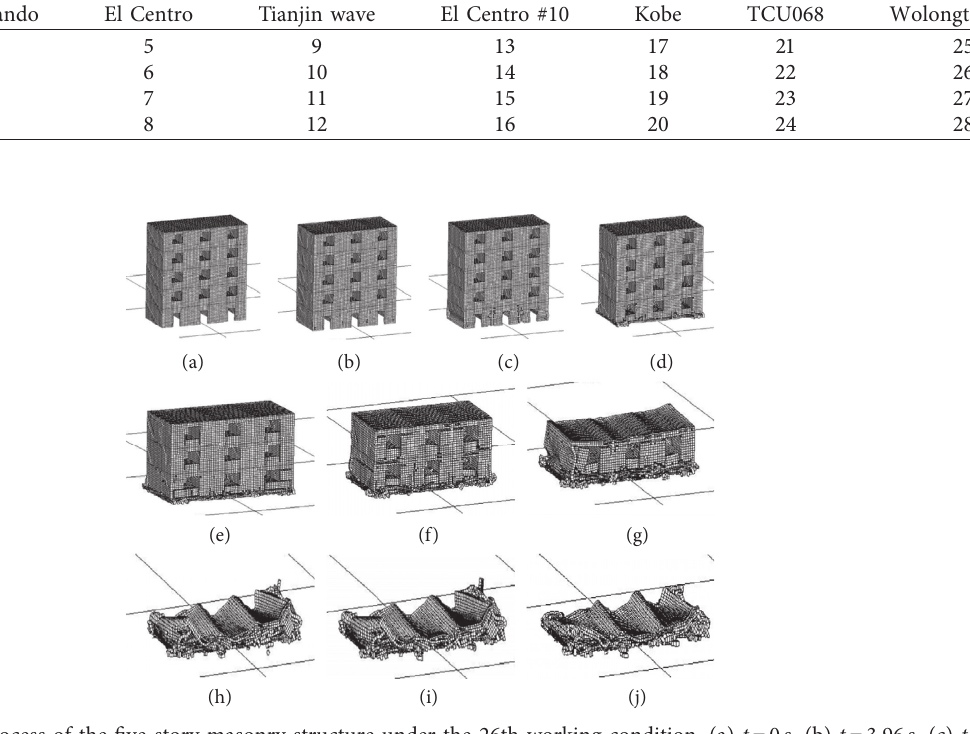
Figure 6: Collapse process of the five-story masonry structure under the 26th working condition. (a) t � 0 s, (b) t � 3.96s, (c) t � 4.86s, (d) t � 5.66s, (e) t � 6.09s, (f) t � 6.48s (g) t � 6.83 s, (h) t � 7.35 s, (i) t � 7.50 s, and (j) t �